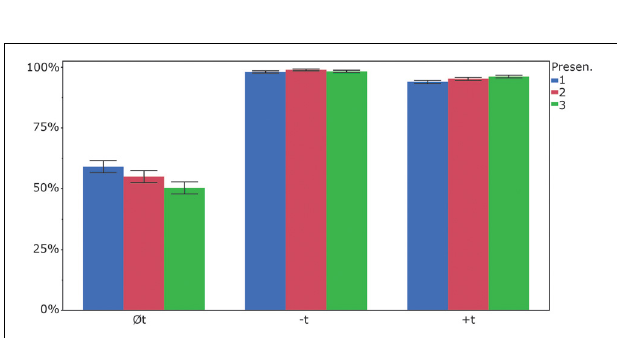
FIGURE 3 | Percent correct responses (“no t” for Øt and − t-items ; “t” for + t-items ) for the three